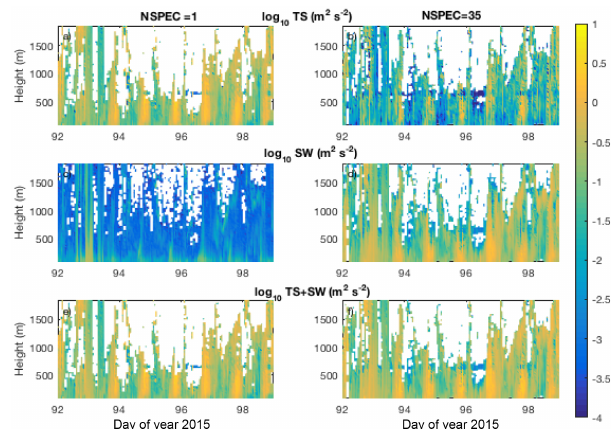
Figure 14. Same as Fig. 13 but for the 915MHz WPR, using NSPEC = 1 (a, c, e) and NSPEC = 35 (b, d, f)